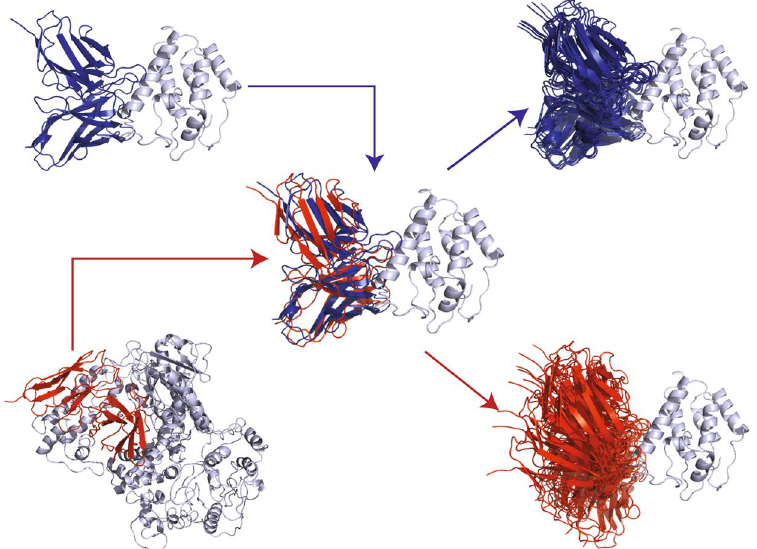
Figure 1. Generation of cognate and non-cognate antibody–antigen complexes. The starting structures for cognate models (blue) are the crystal complexes, while the starting non-cognate models are generated by superimposing the V L –V H framework of the non-cognate antibody (red) on the cognate antibody in the crystal complex. A customized version of RosettaDock’s high-resolution stage is then used to generate an ensemble of models focused around the epitope for